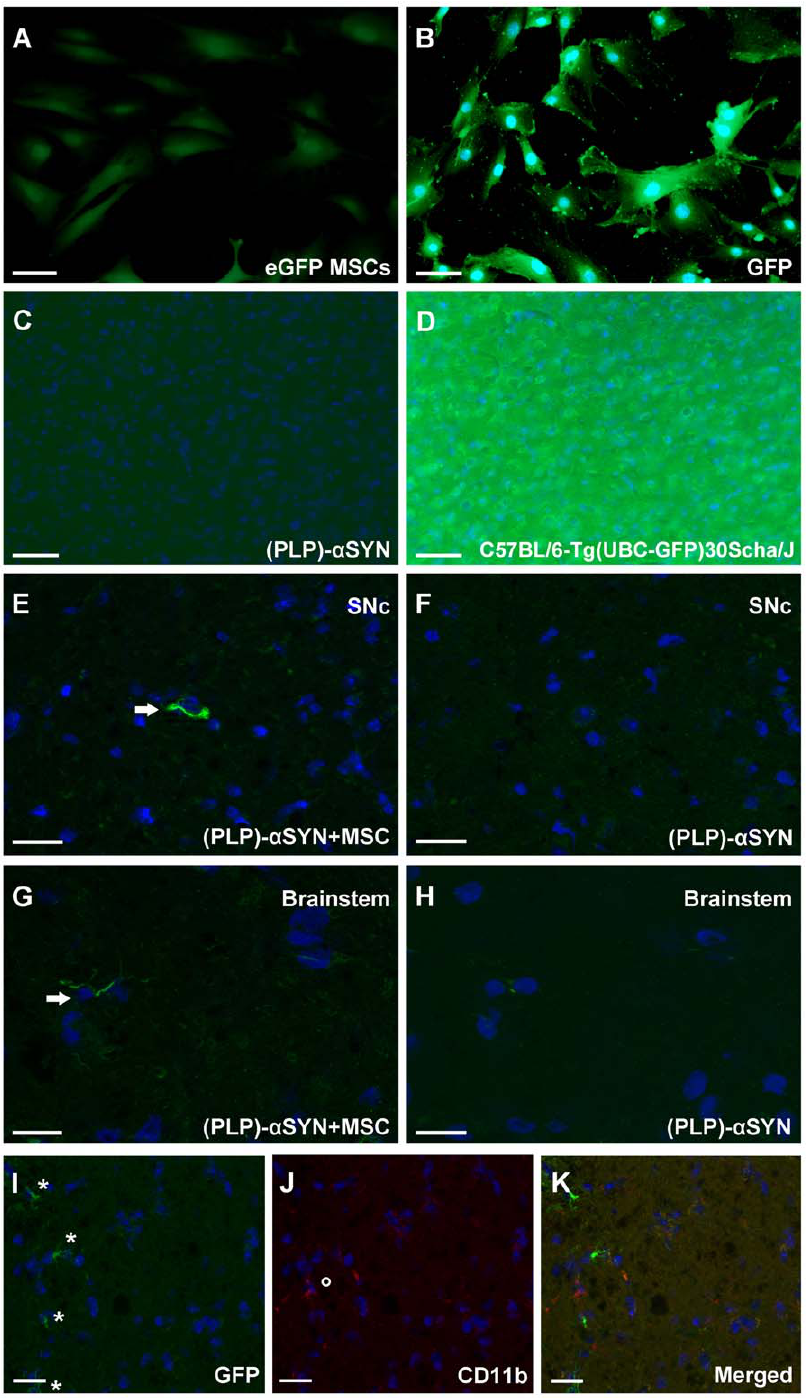
Figure 1. Tracing of intravenously infused GFP + MSCs in aged (PLP)- a SYN transgenic mice. ( A ) GFP + MSCs in culture showed diffuse green fluorescence which could be further enhanced by immunocytochemistry using GFP antibody ( B ). To control the same GFP antibody in brain sections, negative- ((PLP)- a SYN mice, C ) and positive (C57BL/6-Tg(UBC-GFP)30Scha/J transgenic mice, D ) tissue sources were applied. Scale bars ( A , B , C , D ) represent 50 m m. Single GFP + MSCs could be observed, throughout the brain in transplanted animals, by ApoTome confocal-like images of SN ( E ) and brainstem ( G ). Negative control sections of GFP staining in (PLP)- a SYN mice of SN ( F ) and brainstem ( H ). Scale bars ( E , F, G, H ) represent 20 m m. Arrows indicate GFP + MSCs. ApoTome confocal-like images of GFP ( I ) and CD11b positive cells ( J ) in PLP- a SYN + MSC mice. The merged image ( K ) indicates that GFP + cells do not colocalize with CD11b + cells. Asterisk indicate GFP + cells, circle indicates CD11b + cell. Scale bars ( I , J , K ) represent 20 m m. GFP, green fluorescent protein; SN, substantia nigra.